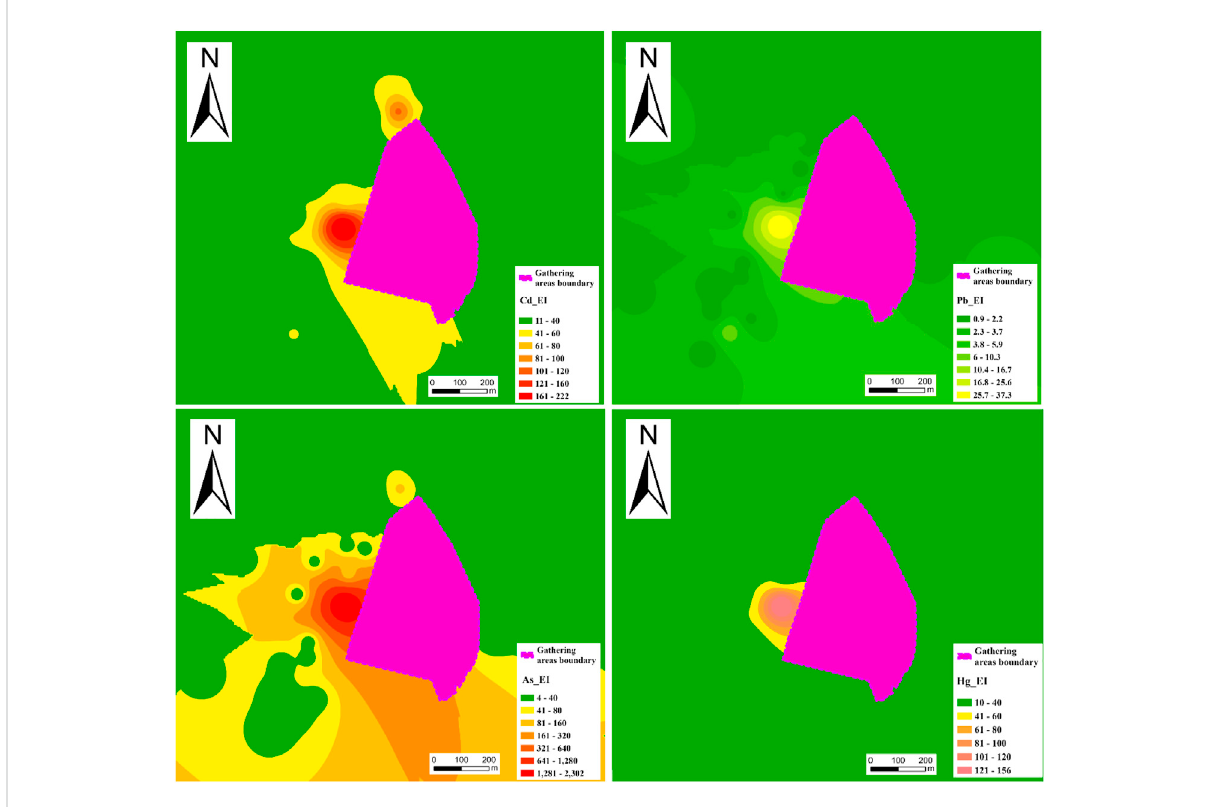
FIGURE 5 Geographical distribution of potential ecological risk (EI) for four heavy metals.